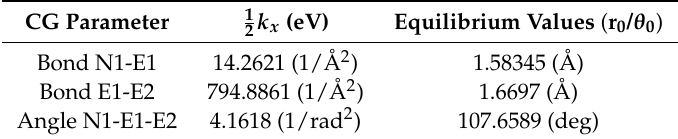
Table 1. Parameters for the CG EAN, shown in Figure 1b, bonded interactions.